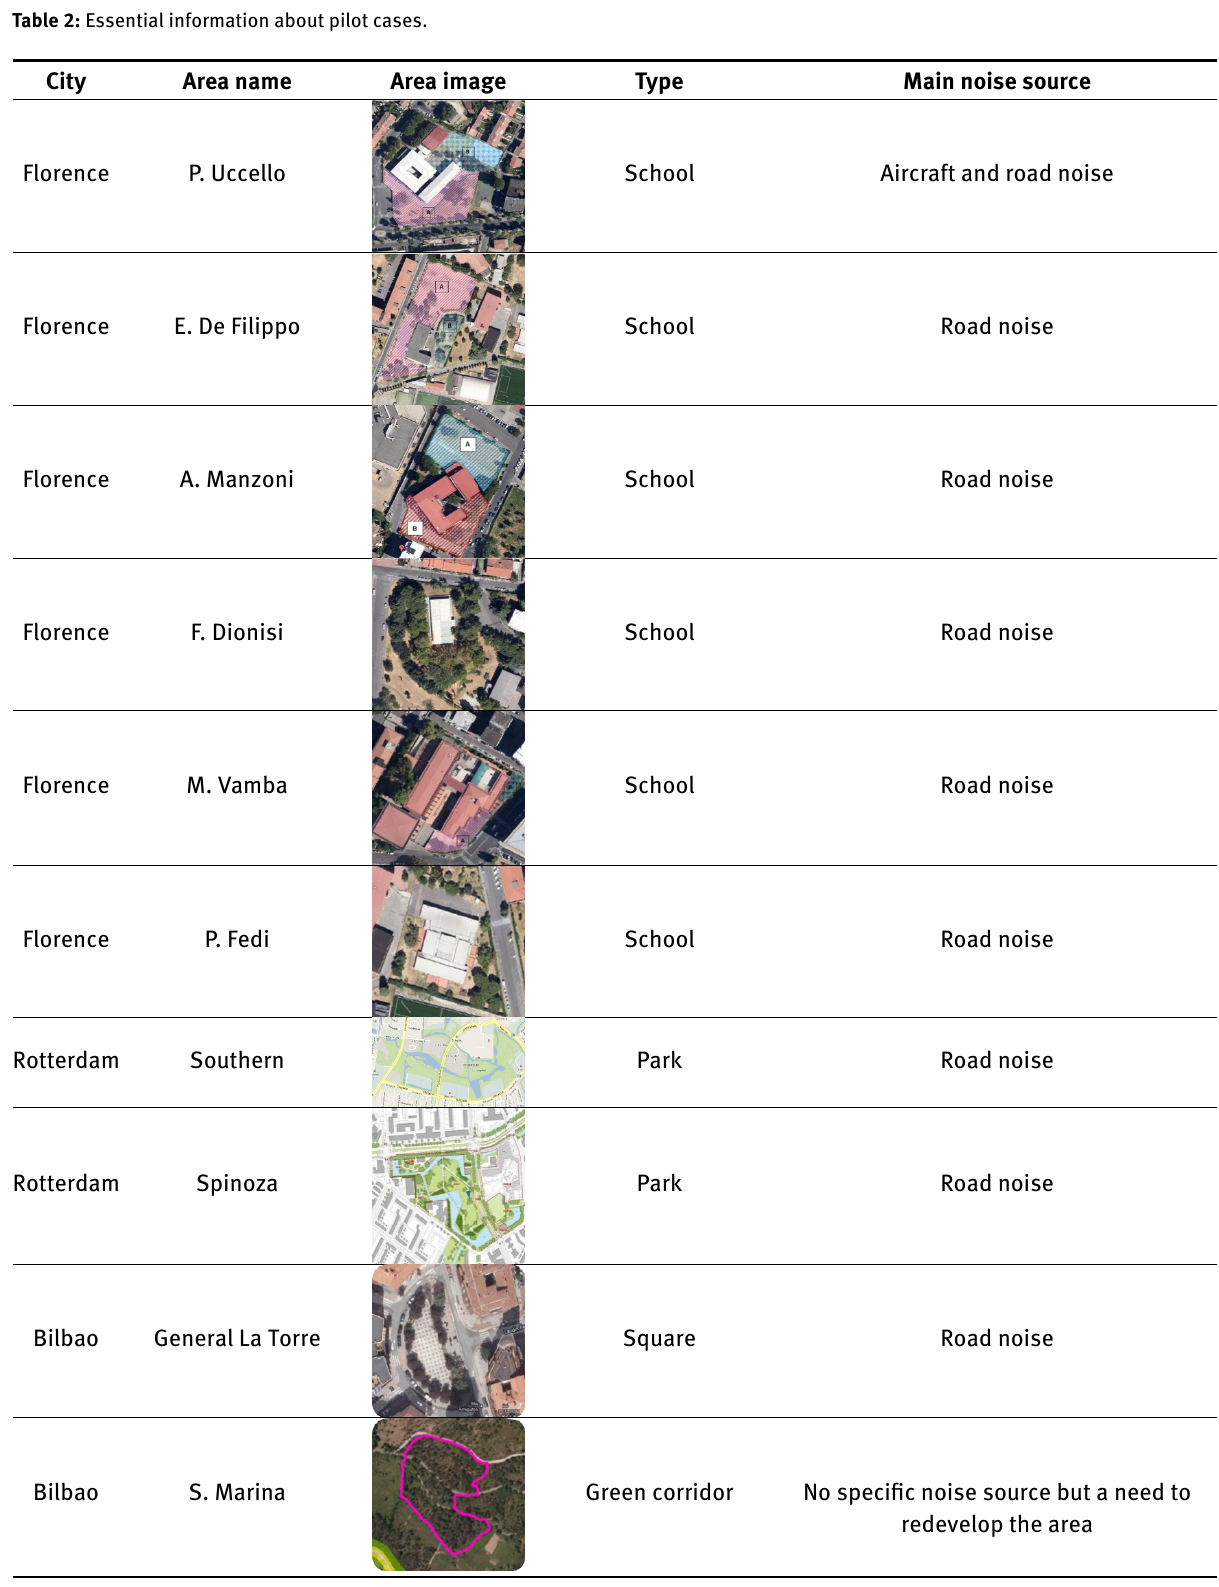
Table 2: Essential information about pilot